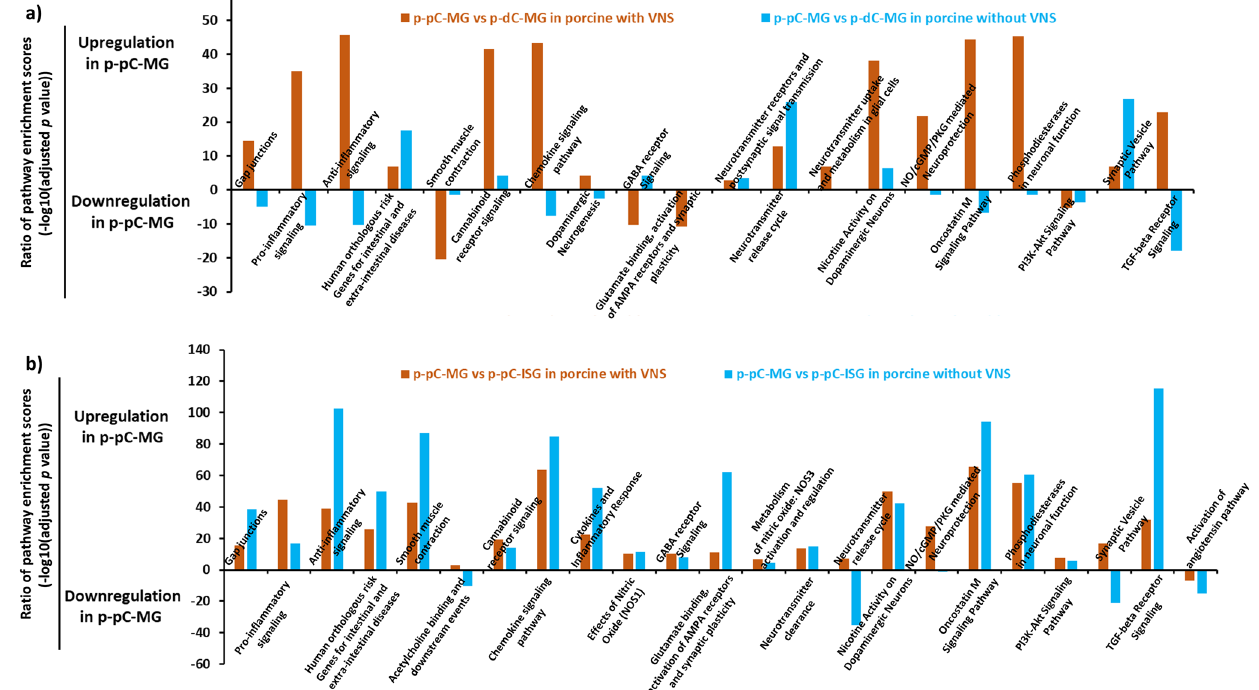
Fig. 7 Comparison of pathway enrichment in myenteric ganglia (MG) between porcine proximal and distal colon (p-pC, p-dC), and between MG and inner submucosal ganglia (ISG) with and without vagal nerve stimulation (VNS). The fi gures show the enrichment ratio of the same WikiPathway involving upregulated and downregulated genes in each list of differentially expressed genes based on the bulk RNA sequencing data from MG of p-pC and p-dC a and MG and ISG of p-pC b . The light blue color represents the enrichment ratio without VNS and the orange color represents the enrichment ratio with